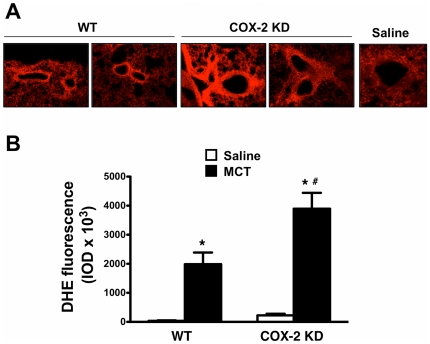
Oxidative stress is exacerbated in lungs from COX-2 KD mice after MCT treatment.A. Images from MCT-treated mice (20x objective) revealing intense DHE fluorescence in pulmonary arterioles. The image of a DHE-fluorescing arteriole (40x) from a saline control was included for comparison to indicate background fluorescence. B. Intensities of DHE fluorescence are summarized in graph format and expressed as integrated optical densities (IOD). Lung sections (n = 7–27) from 4–7 mice from each treatment group are represented as averaged fluorescence values. DHE, dihydroethidine. *, p<0.05 vs saline; #, p<0.05 vs MCT-treated WT.